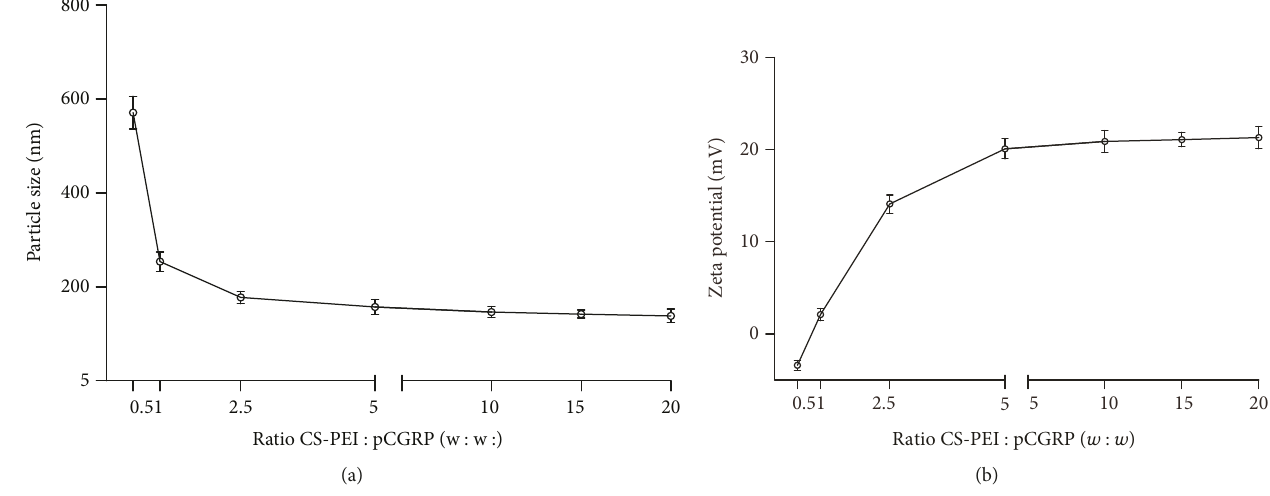
Figure 3: Physical properties of CS-PEI/pCGRP with di ff erent mass ratios of CS-PEI to pCGRP. (a) Particle size and (b) zeta potential of di ff erent CS-PEI/pCGRP nanoparticles.